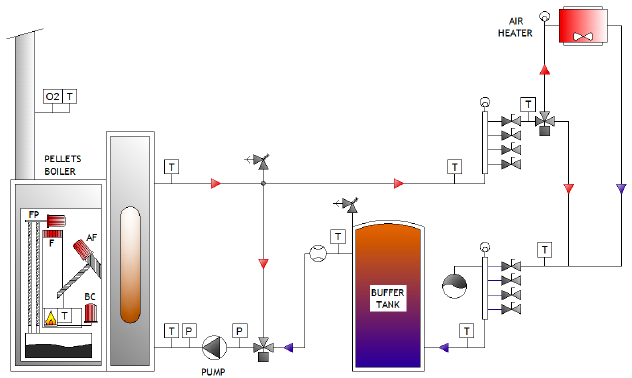
Figure 1. Schematic layout of the plant.